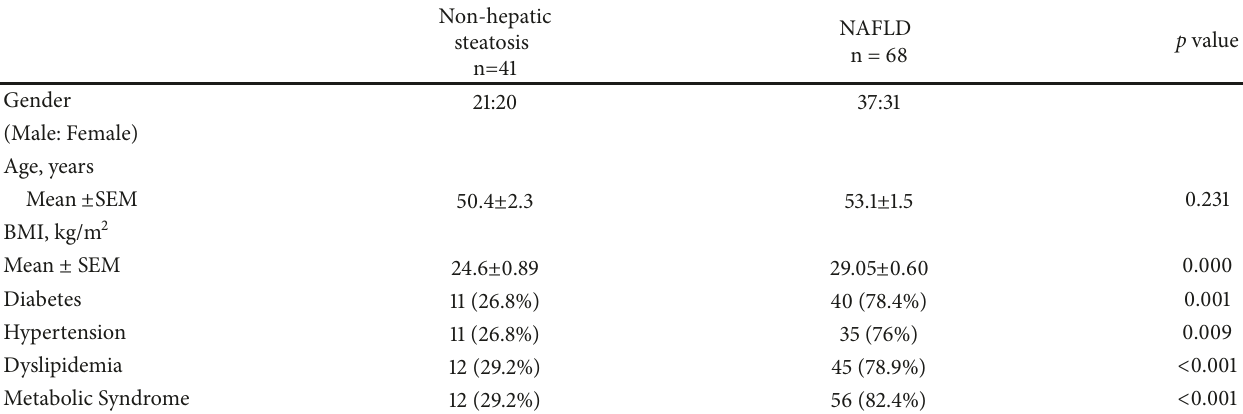
Table 1: Patients’ characteristics and comorbid conditions. NAFLD: nonalcoholic fatty liver disease; BMI: Body Mass Index; SEM: Standard Error of